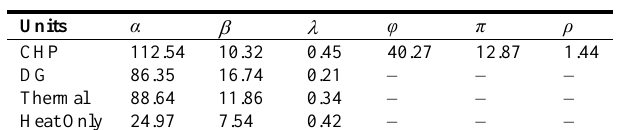
Fig. 1. Configuration of the 21-bus microgrid system. TABLE I C OST FACTORS OF U NITS